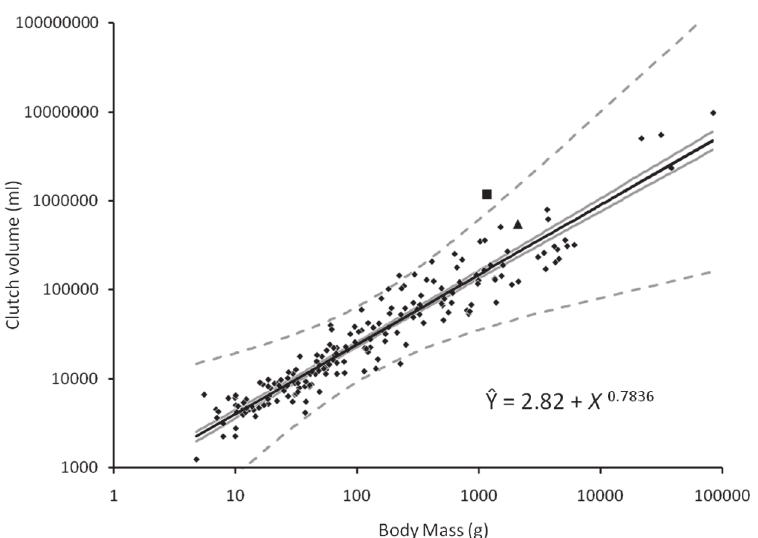
Fig 2. Family means of clutch volume in relation to the mean body mass for avian families (families follow Dickinson 2003), grey lines denoting confidence intervals (standard error) and dotted lines defining 95% confidence intervals. Megapodes (denoted by a square) represent the only outlier with a clutch volume more than 10 standard deviations greater than the value predicted by body mass. The clutch volume of Kiwis (Apterygidae; denoted by a triangle) is not significantly greater than the value predicted by body mass.